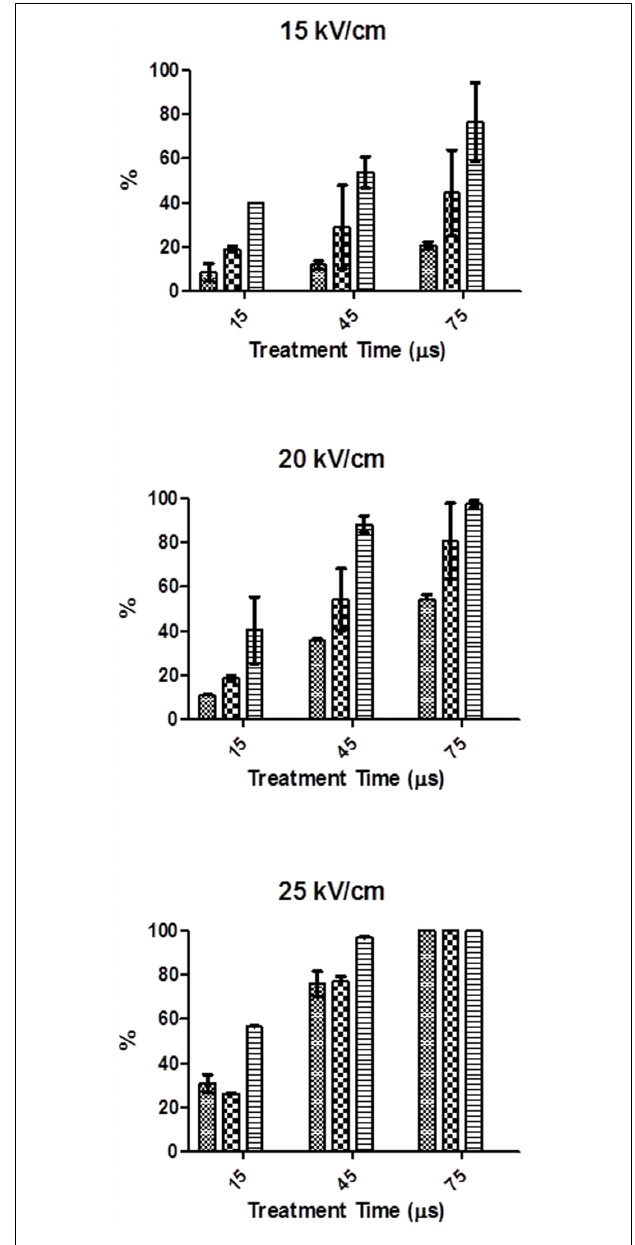
FIGURE 2 | Percentage of S. cerevisiae cells inactivated and stained when propidium iodine (PI) was add before or after PEF treatments of different electric field strength and treatment time. 512 % of stained cells when PI added after PEF treatment, % of stained cells when PI added before PEF treatment, % of inactivated